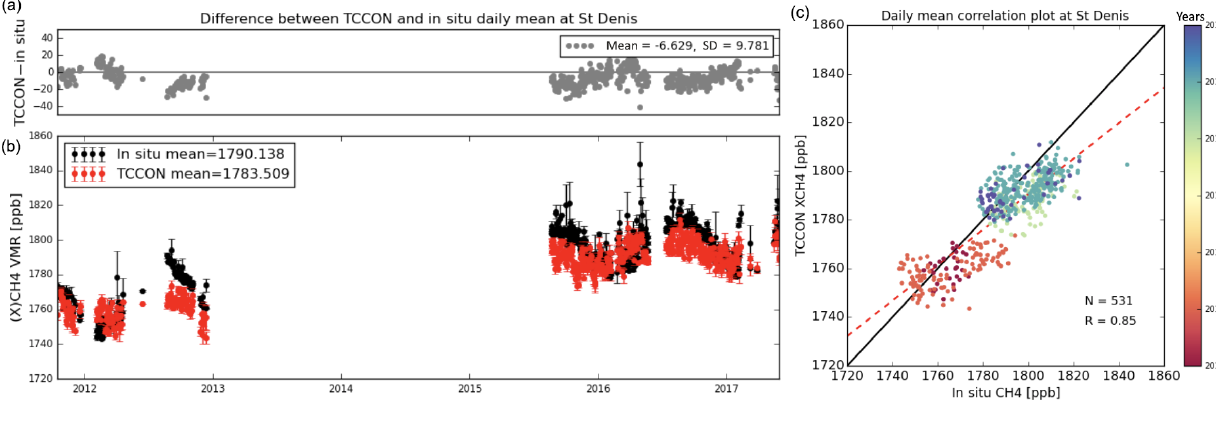
X CO , p in the vertical ranges of surface–8 km and 8–20 km following Eq.